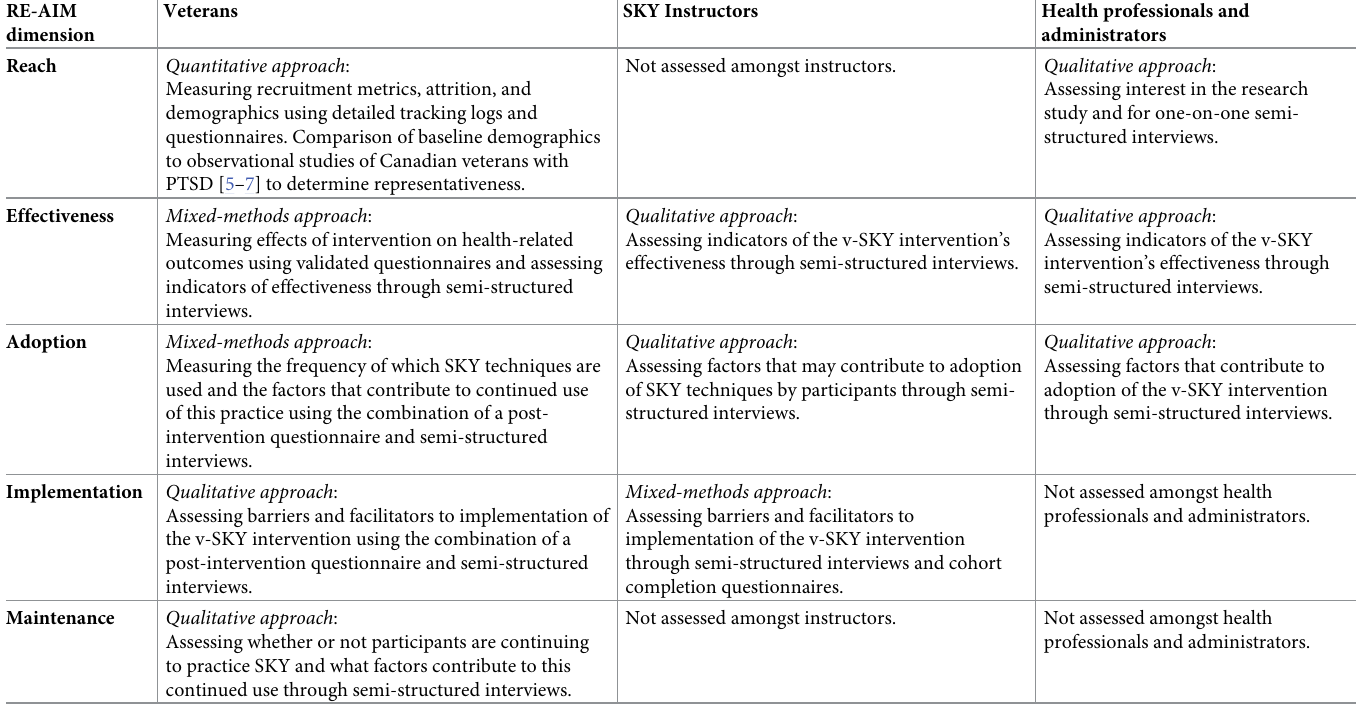
Table 5. Descriptions of the methodological approaches used to assess each RE-AIM dimension in each population. RE-AIM dimension Reach